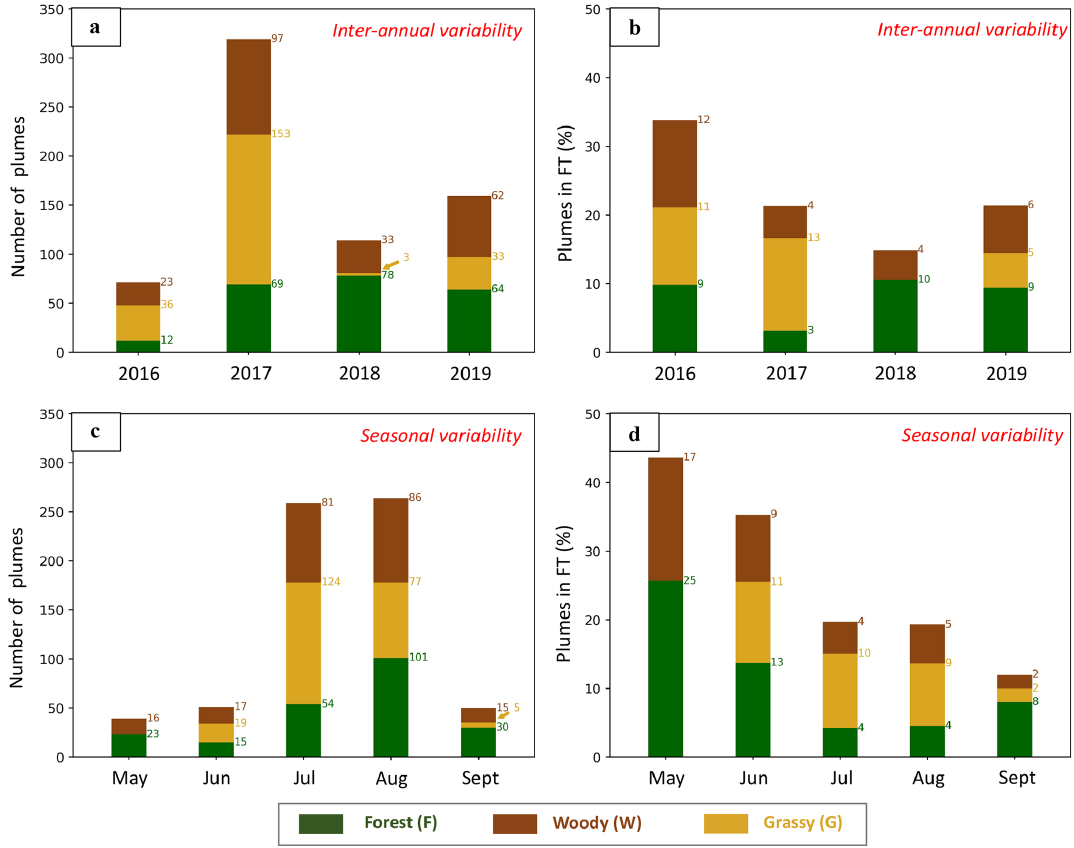
Figure 2. Seasonal and inter-annual variability in the plume number (a, c) and the percentage of those plumes in the free troposphere (FT) (b, d) . Each bar is divided by color according to the relative contribution from each of the three fire types in the given month or year, with quantitative annotations. For example, 39 plumes were identified in the month of May (c) , 16 of which were W fires and 23 of which were F fires. Of the 39 fires that month, ∼ 42% were in the FT ( ∼ 17% classified at W fires, and ∼ 25% classified as F fires) (d) . Note that differences in rounding (for the sake of simpler visualization here) produce slightly different numbers compared with the percentage of plumes in the FT given in Table 2. A plume is considered to be in the FT if its median height is 100m greater than the PBL height as defined in the MERRA-2